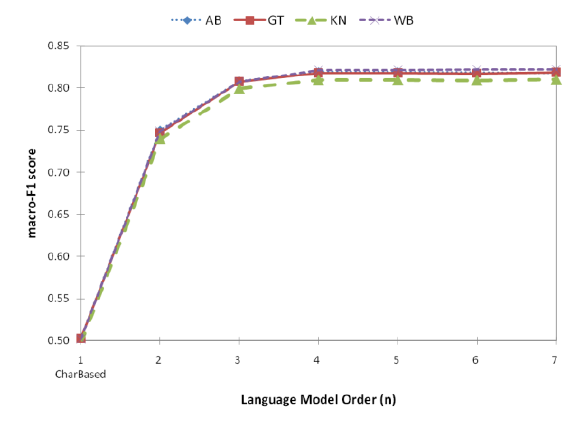
Fig. 6. Performance of the FirstFLetter ( F = 3,…,7) based language models with Good-Turing smoothing method along with language model order